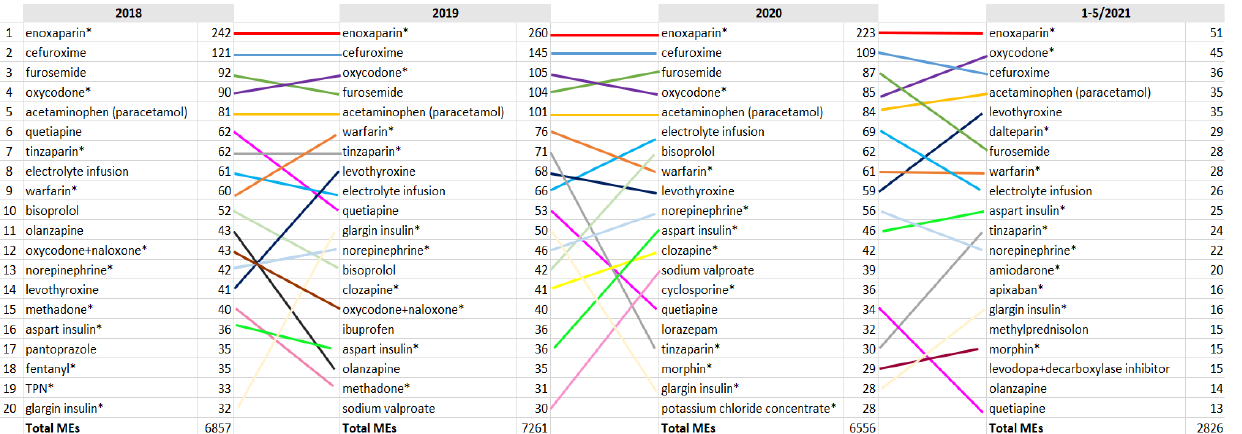
Figure 3. Trends in the reporter contributing factors related to MEs during 1/2018–5/2021. * Different implantation phases (Go-lives = GLs) GL1: 11/2018, GL 2.1: 2/2020 and GL 2.2. 10/2020. Contributing factors that were not included in the figure include organisation and management (only 0–5 reports per month) and not known contributing factors.